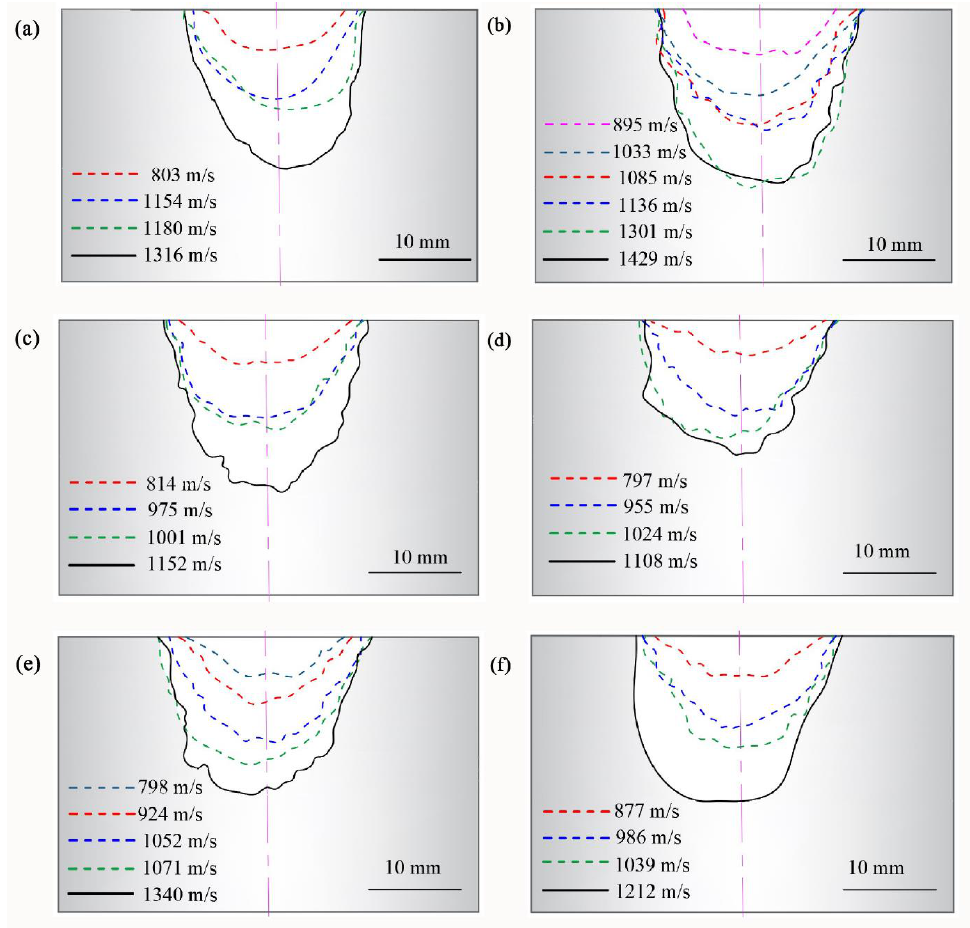
Figure 15. The effects of the projectile hitting the target: ( a ) Steel, FeNiCoCr HEAs annealed at ( b ) Initial, ( c ) 600 °C, ( d ) 750 °C, ( e ) 850 °C and ( f ) 1000 °C. The results of penetration were normalized to study the performance of the projectile penetrating targets with the same kinetic energy, as shown in Figure 16. As the impact kinetic energy increased, the DOP and VOC of the LRPs of FeNiCoCr HEA annealed at 850 °C were similar to that of the steel LRPs. Among all five kinds of FeNiCoCr HEAs, the penetration performance of the alloy annealed at 600 °C performed the best. Compared with those of the steel LRPs, the DOP and VOC of LRPs of the alloy annealed at 600 °C were increased by 43% and 78%, respectively. Impact velocity played a more vital role in the FeNiCoCr HEAs annealed at 1000 °C than the FeNiCoCr HEAs with other annealing temperatures, while the penetration performance of the LRPs of FeNiCoCr HEA annealed at 850 °C is similar to that of the steel LRPs.